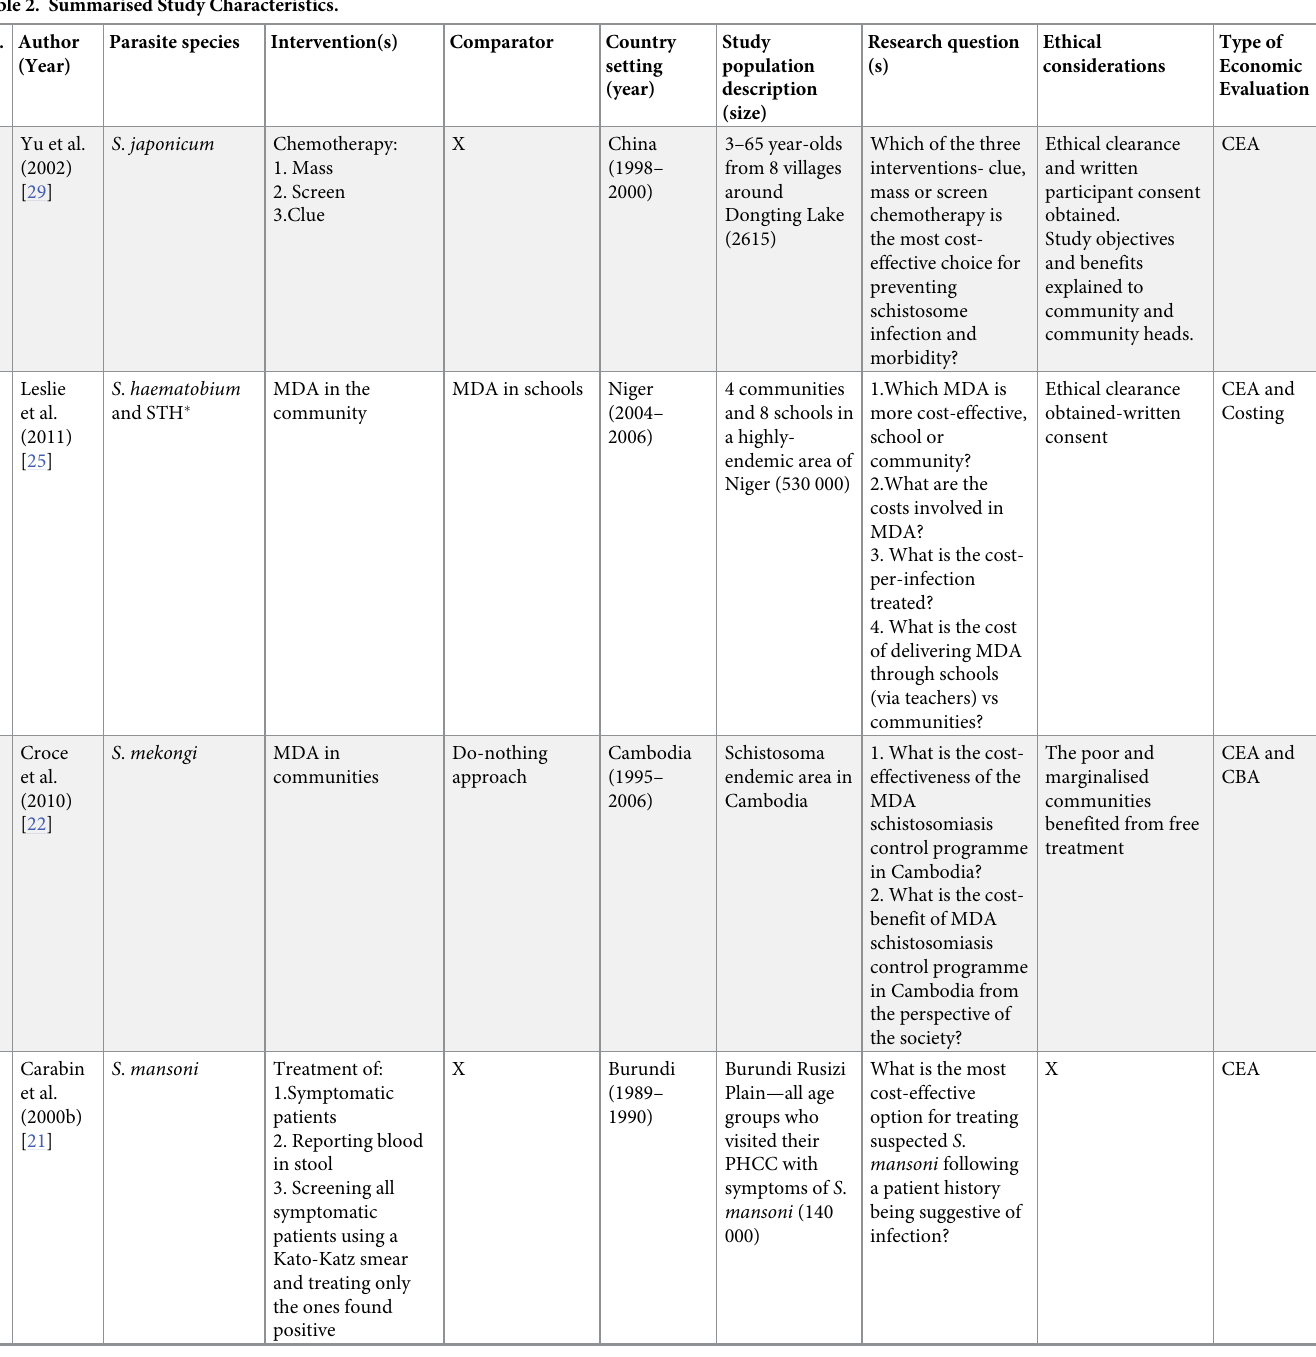
Table 2. Summarised Study